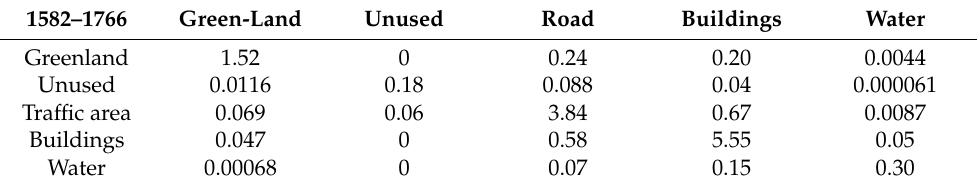
Figure 6. Land-use change Statistics. Table 3. Land use transfer matrix from 1582 to 1766/km 2.